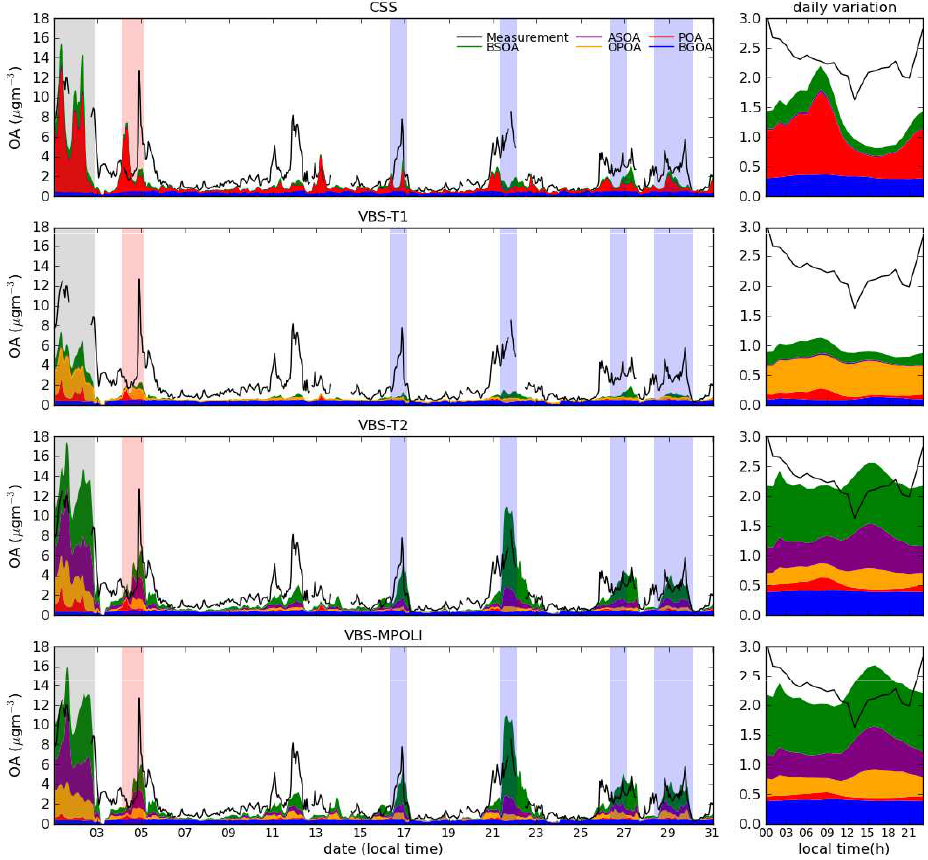
Fig. 9. As in Fig.7, but for